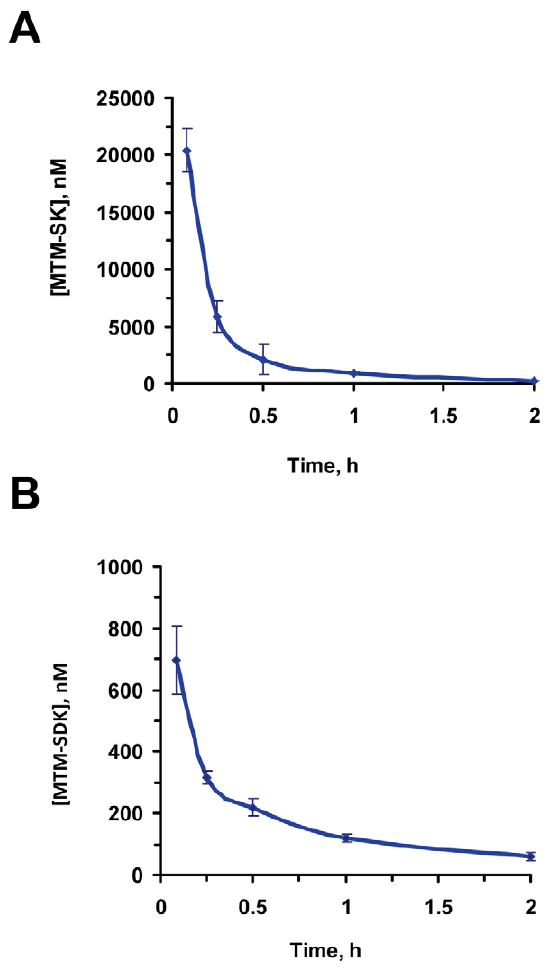
Figure 3. Pharmacokinetics profile of MTM-SDK and MTM-SK in mice. Mice (n=3/group) received a single IV injection of MTM-SK (A) or MTM-SDK (B) and plasma levels were determined by LC-MS. Doses of MTM-SK and MTM-SDK were 18 mg/kg and 2 mg/kg, respectively.